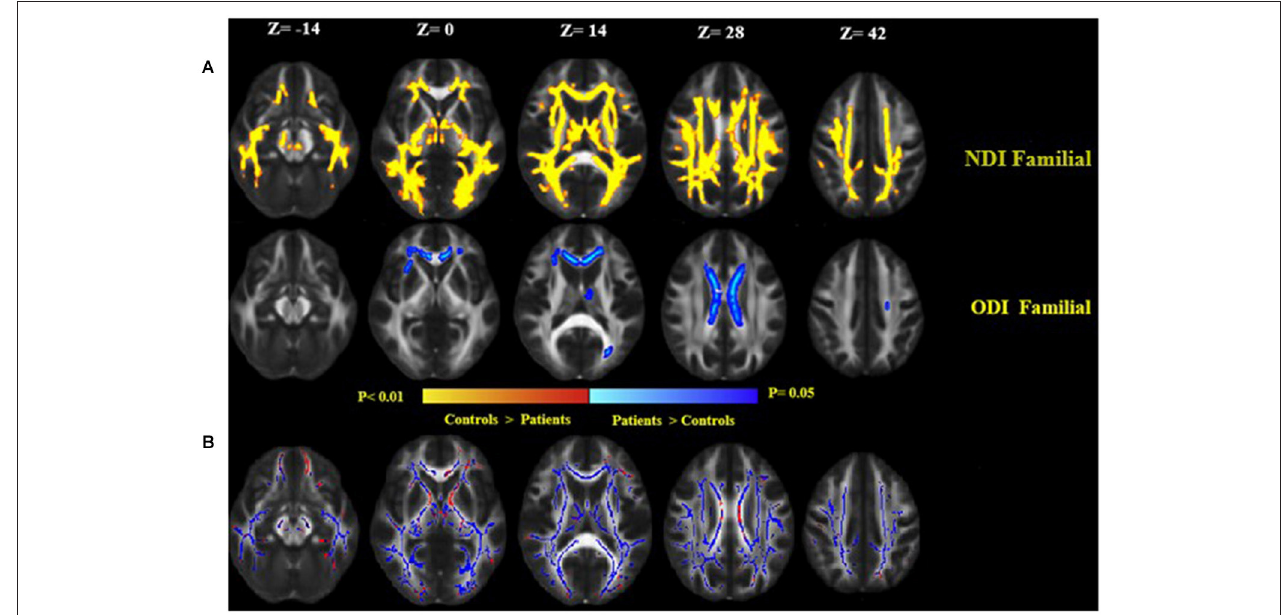
FIGURE 4 | (A) Widespread alterations in NODDI parameters [neurite density index (NDI) and neurite orientation dispersion index (ODI)] found in patients as demonstrated by TBSS. NDI and ODI show regional differences in patients as compared to healthy controls. NDI was lower throughout the central white matter in patients as compared to healthy controls, while ODI increased in patients than controls. Significant changes in NDI and ODI reflect widespread disruption of white matter in the familial group. (B) Clusters of voxels with significantly decreased NDI in blue are overlaid on the FA. FA was lower in the white matter in familial MS patients as compared to healthy controls (red). Images are displayed in radiological convention with a left hemisphere on the right